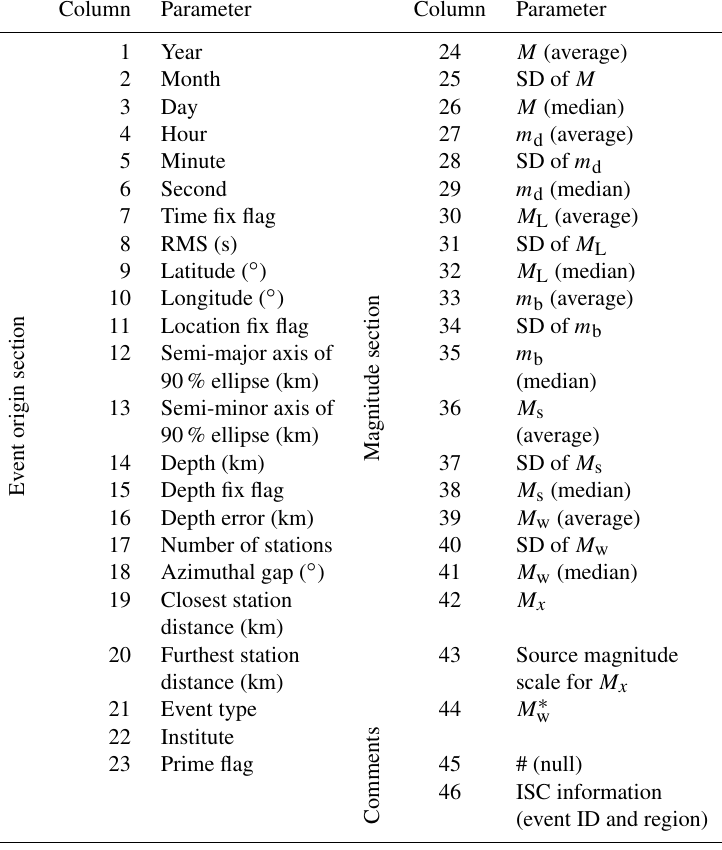
Table B1. Parameters in the homogenized catalogue. Column Parameter Column